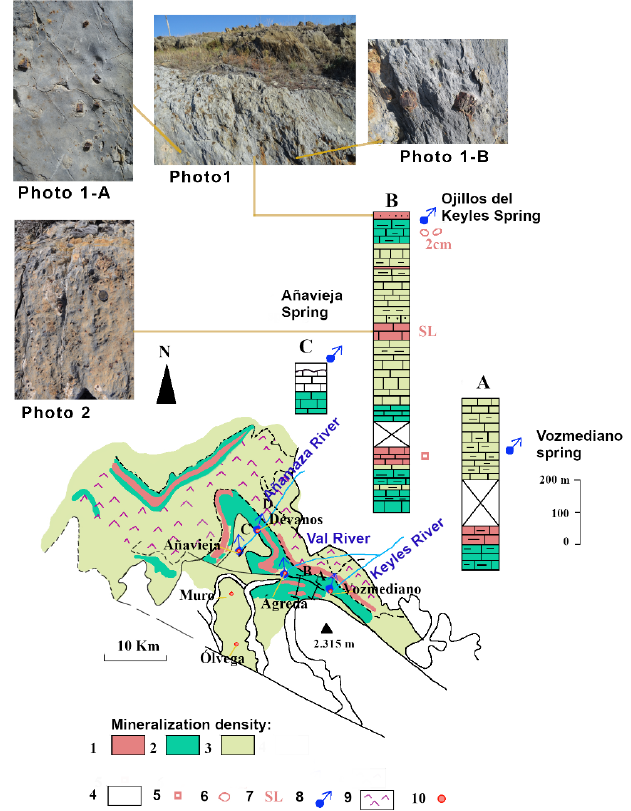
Figure 2. Pyrite distribution in study area. ( A ) and ( B ), Stratigraphic columns in marine Jurassic and density of pyrite mineralization. ( C ). Lithological column of the borehole next to the Añavieja spring. Mineralization density: (1) high, (2) medium, (3) low. (4) Geological formations without pyrites, (5) cubic crystals of limonitised pyrite on surface (in cm, maximal length of the sides), (6) Fe nodules and pyrite casts, (7) pyrites without limonitisation at the surface, (8) important springs with high relative sulphate content, (9) distribution of gypsiferous plant species Gypsophila hispanic (Willk.) , Herniaria (8) ruticose (L .) and Launaea pumila (Cav . ) These plant species indicate that gypsum is clearly associated with the Oncala Group of the Weald Facies. (10) Towns and villages.